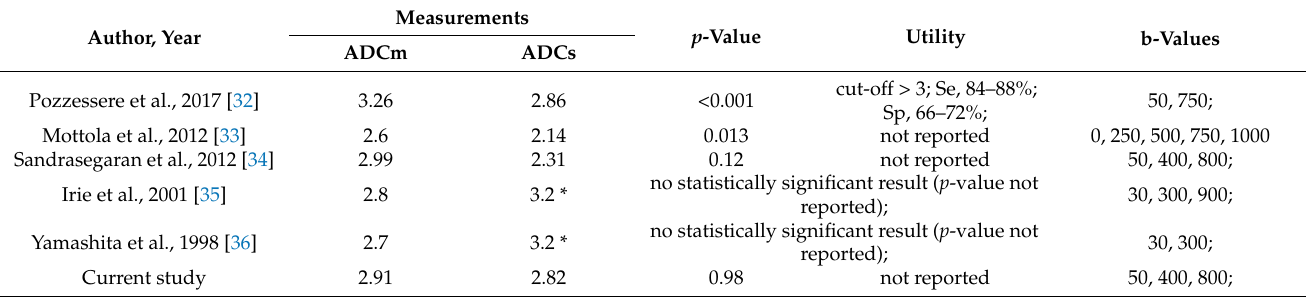
Table 6. Previous studies that used the apparent diffusion coefficient (ADC) values for the differenti- ation of mucinous from serous pancreatic cystic